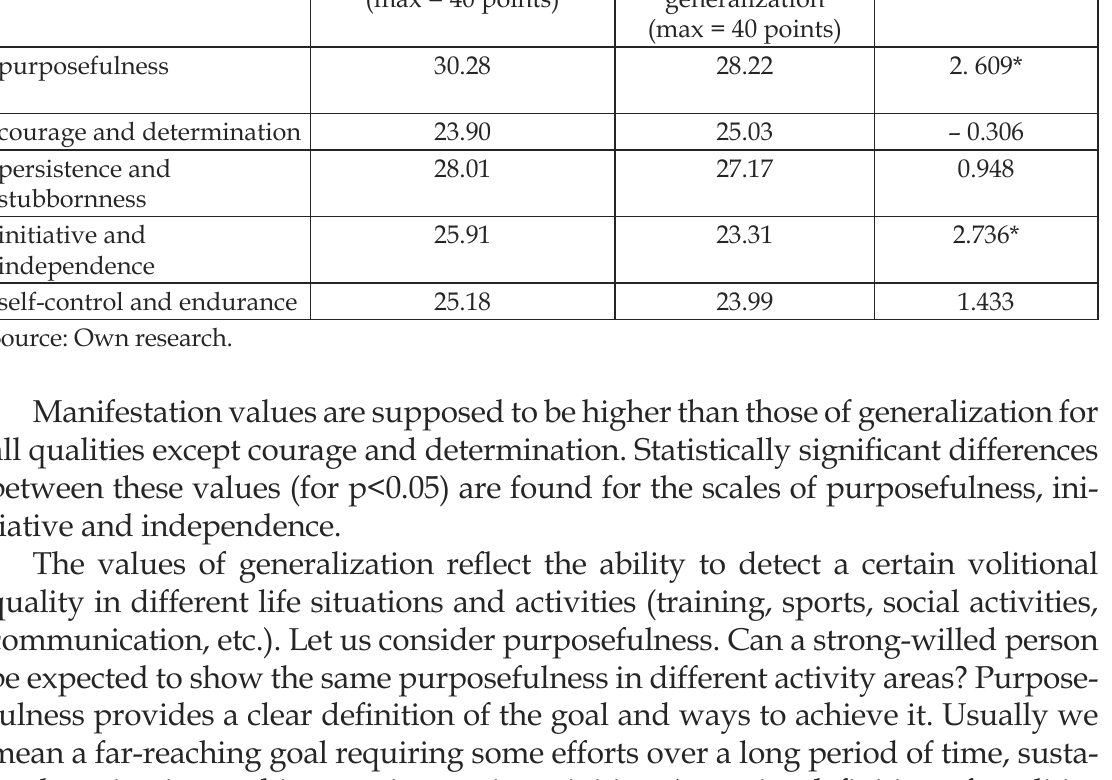
Table 1. The average values in N. Stambulova’s methods scales (t-criterion, that is statistically signi (cid:222) cant for the level of p <0.05, is marked with *). t-criterion volitional qualities values of manifestation values of (max = 40 points) generalization (max = 40 points) purposefulness 30.28 28.22 2. 609* courage and determination 23.90 25.03 – 0.306 28.01 27.17 0.948 25.91 23.31 2.736* 25.18 23.99